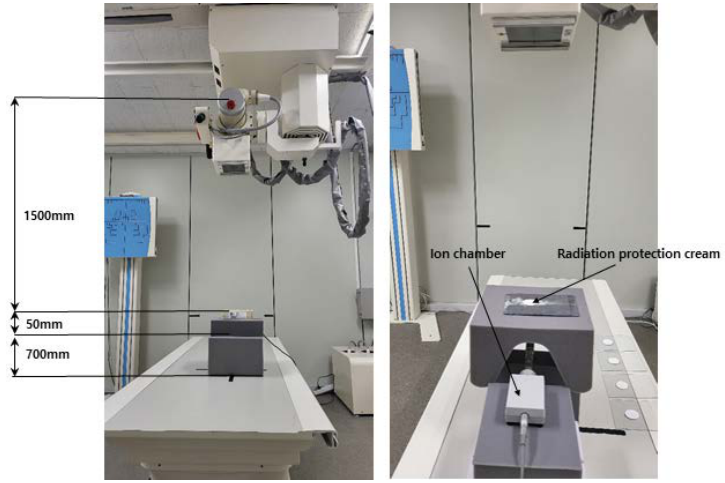
Figure 2. X-ray shielding performance evaluation method.